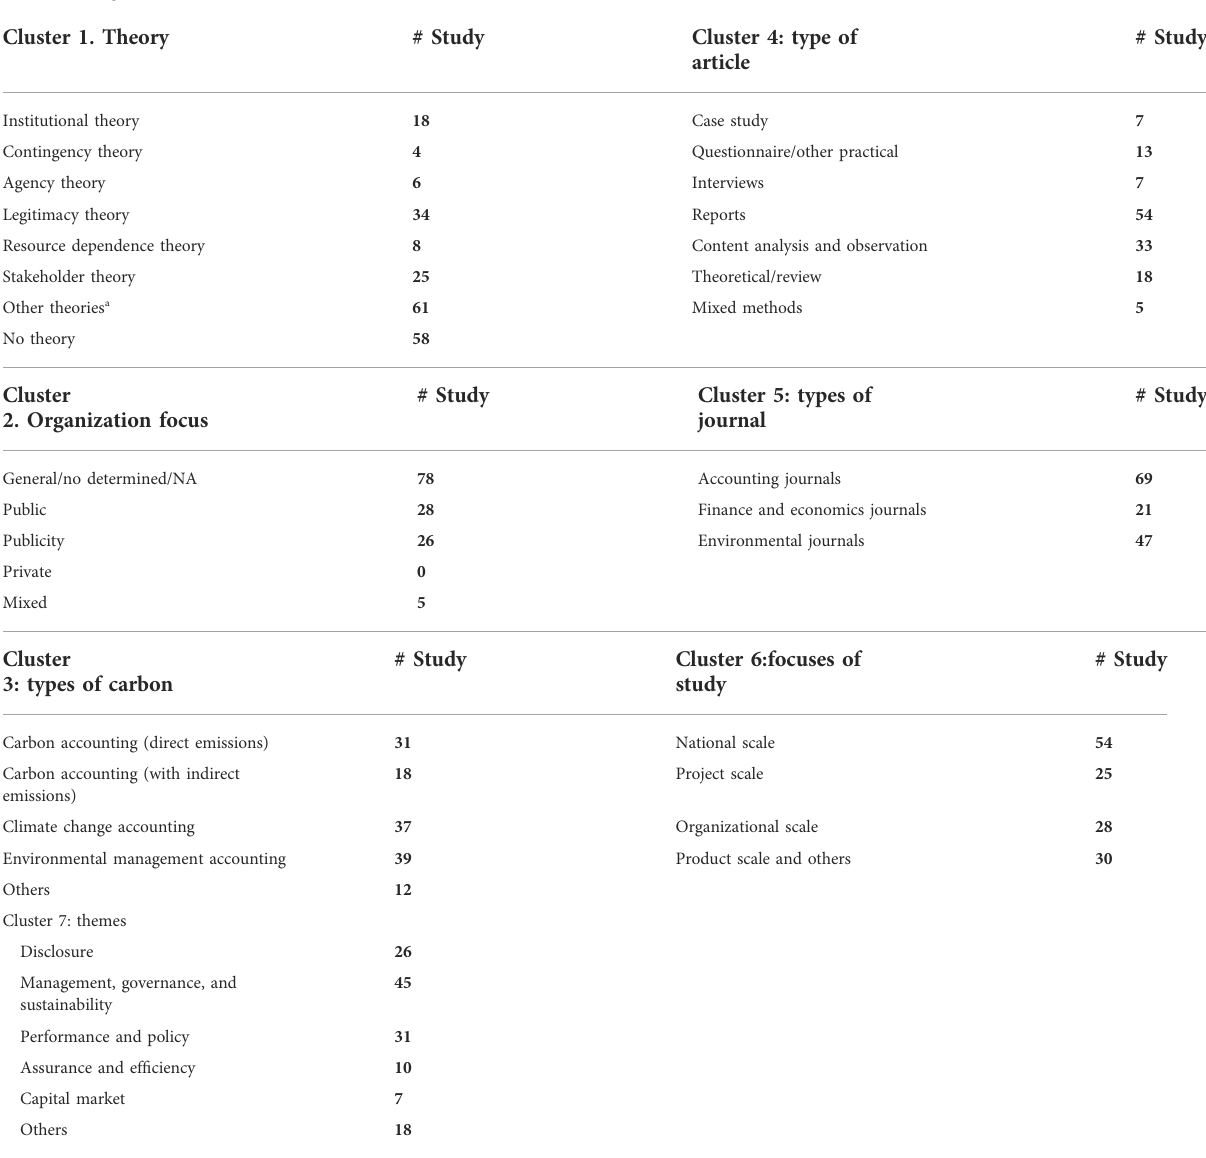
TABLE 2 Analytical framework of the